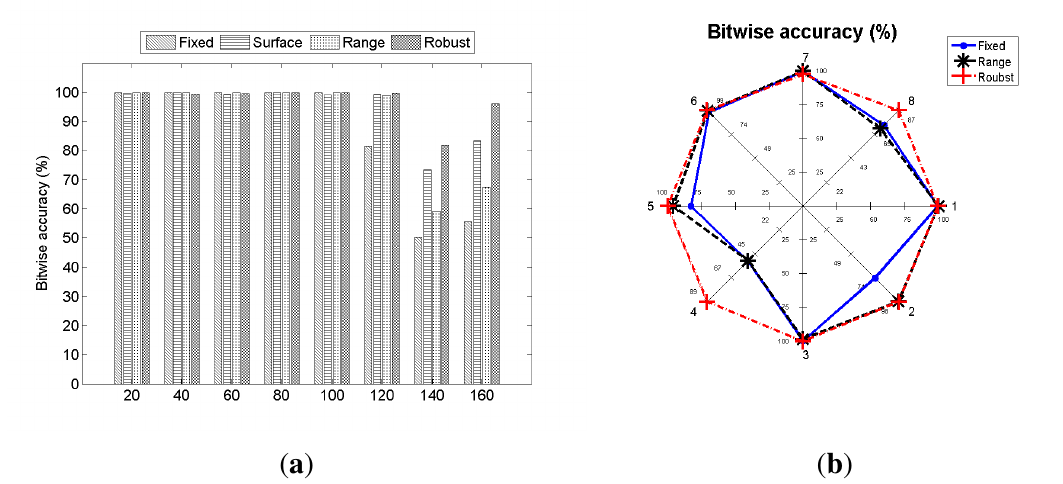
Figure 15. Bitwise accuracies over different distances between the transmitter and the receiver under three different adaptive threshold adjustment methods. Bitwise accuracy at different communication directions from the transmitter when different adaptive threshold adjustment methods are used. The locations of the receiver are shown in Figure